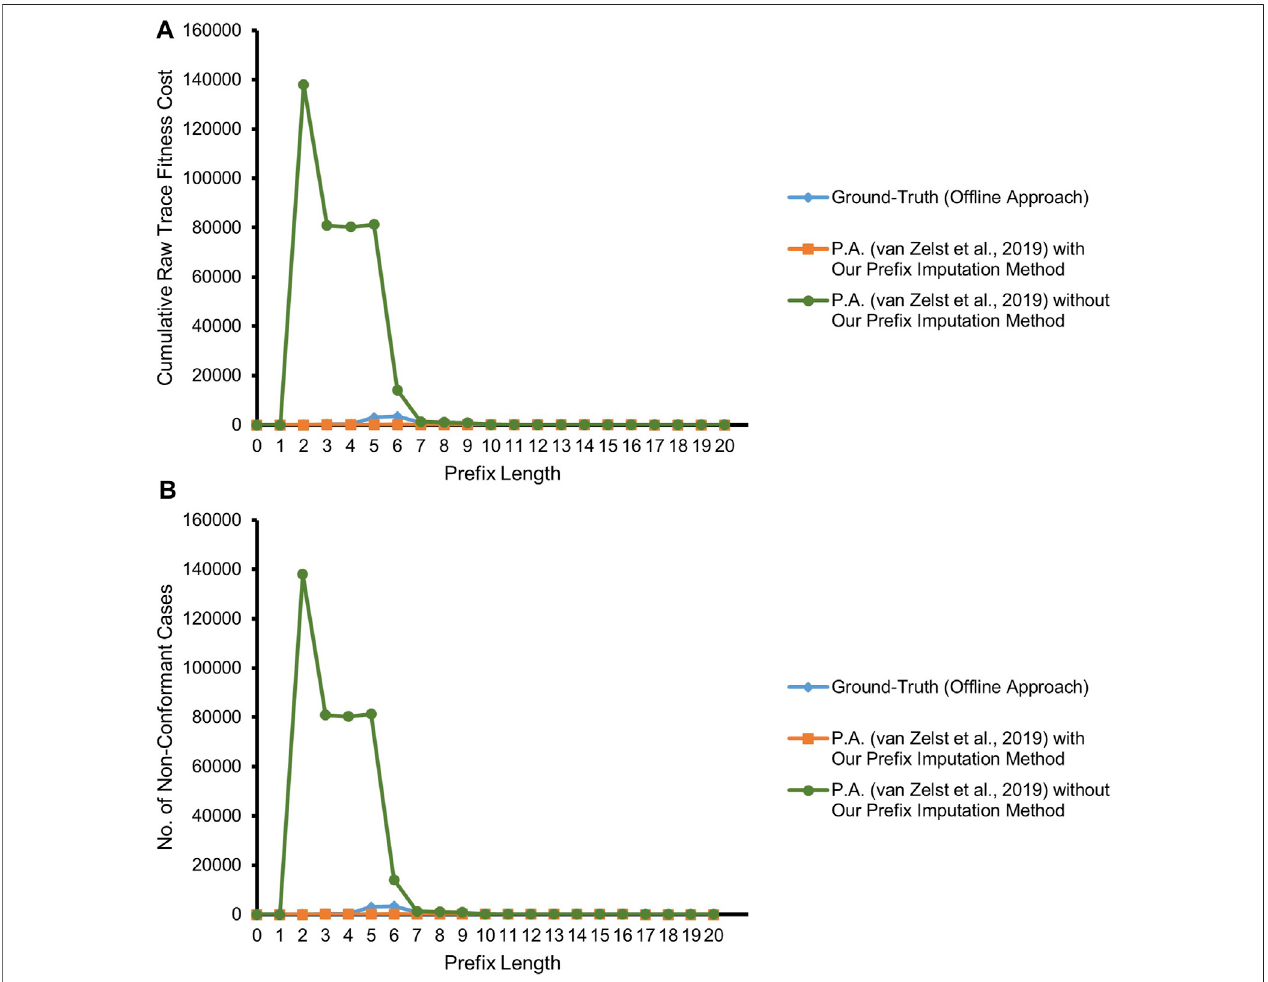
FIGURE 11 | Pre fi x-alignments with and without our pre fi x-imputation method for road traf fi c fi ne management process event data. (A) Cumulative raw trace fi tness cost. (B) Number of non-conformant cases.